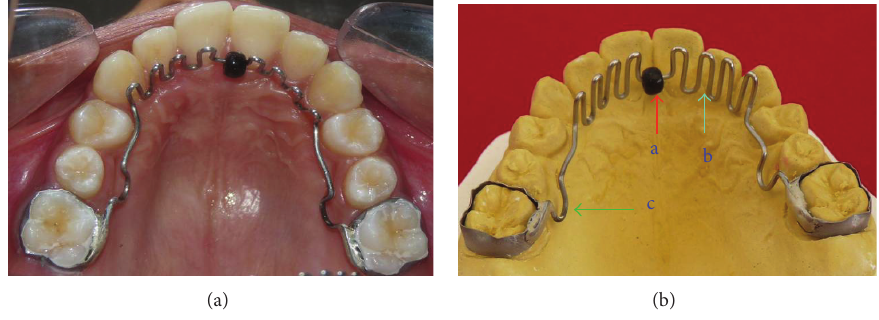
Figure 1: Hybrid Habit Correcting Appliance